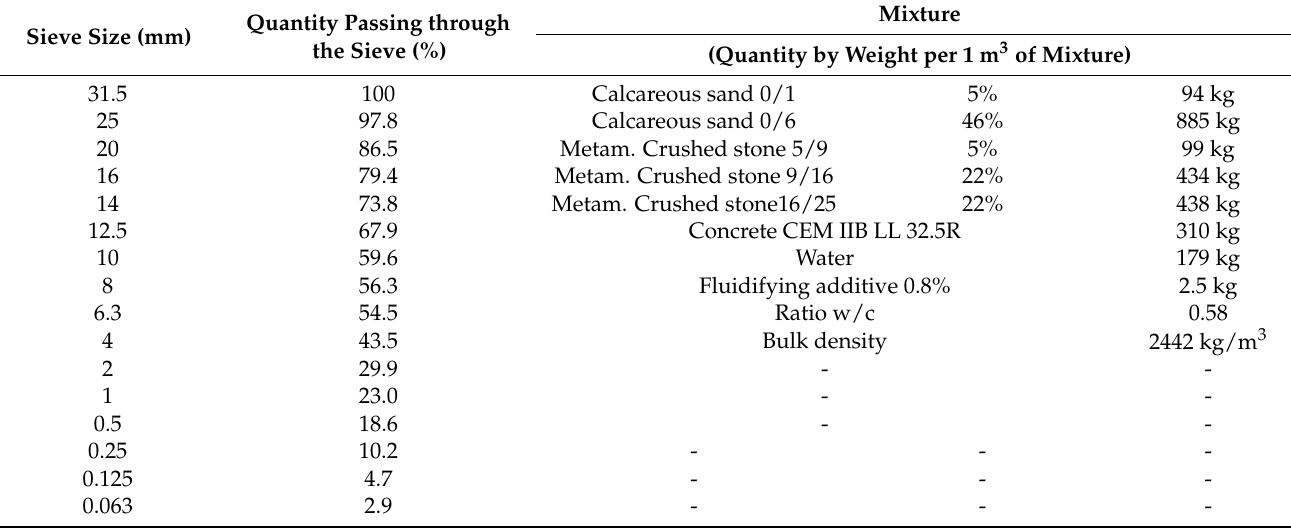
Table 4. Aggregate mixture with metamorphic crushed stone. On the left side, the quantity passing through the sieve expressed in percentage of the metamorphic crushed stone and the sieve size used; on the right side, the component used for the mixture.